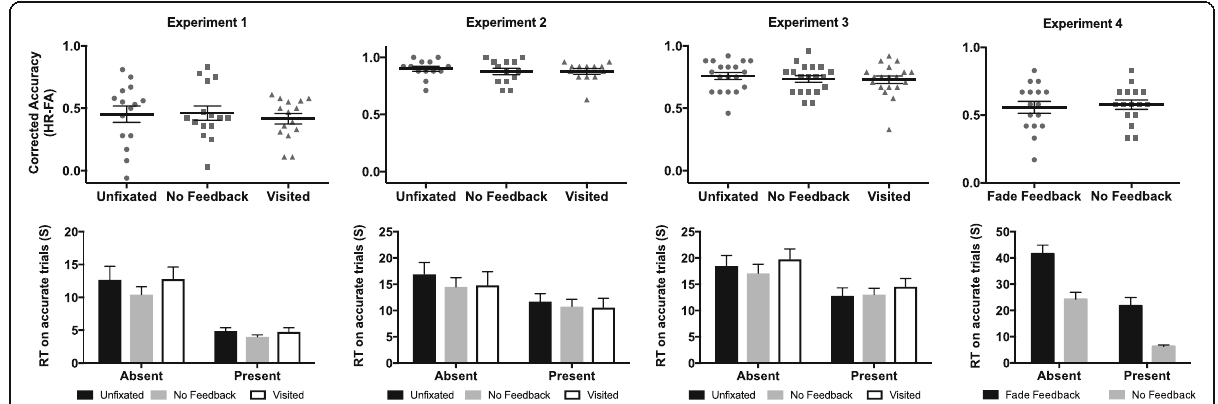
Fig. 2 Results for Experiments 1 – 4. Error bars represent standard error of the mean. Note the varying scales on the response time graphs